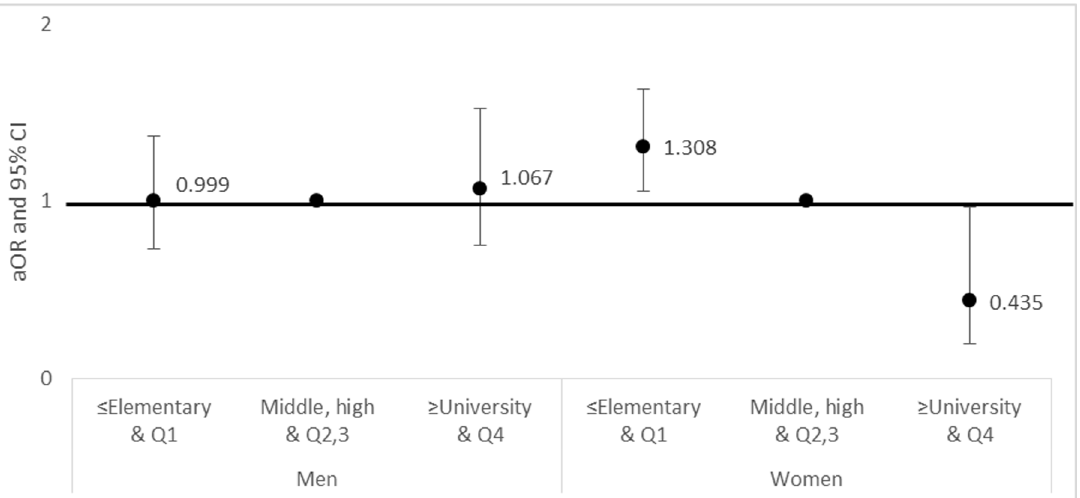
Fig 3. Adjusted OR and 95% CI for blepharoptosis by household income and education. Household income was divided into quartiles and defined as low (Q1), medium-low (Q2), medium-high (Q3), and high (Q4). Education level was classified as elementary school ( (cid:1) 6 years), middle school (7 – 9 years), high school (10 – 12 years), and university ( (cid:3) 13 years). The middle-income and middle-education groups served as reference groups. (A) Men (B) Women. OR, Odds ratio; CI, confidence interval. P <